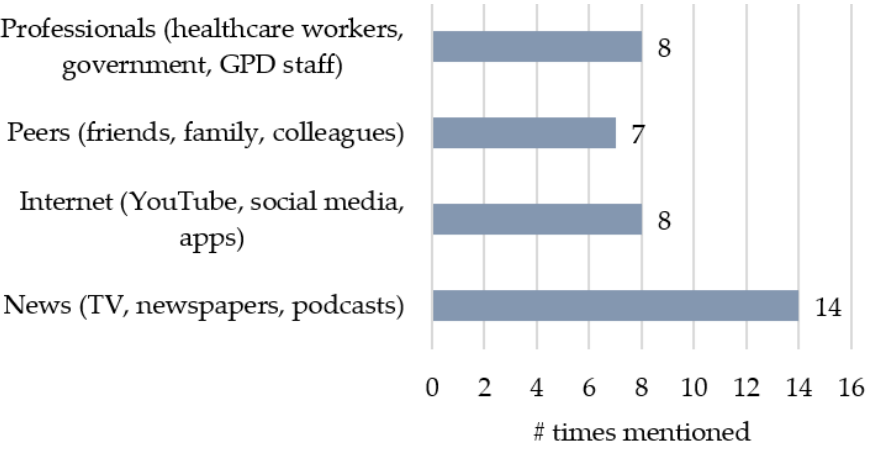
Figure 3. Sources of Information on COVID-19 and COVID-19 Vaccines.